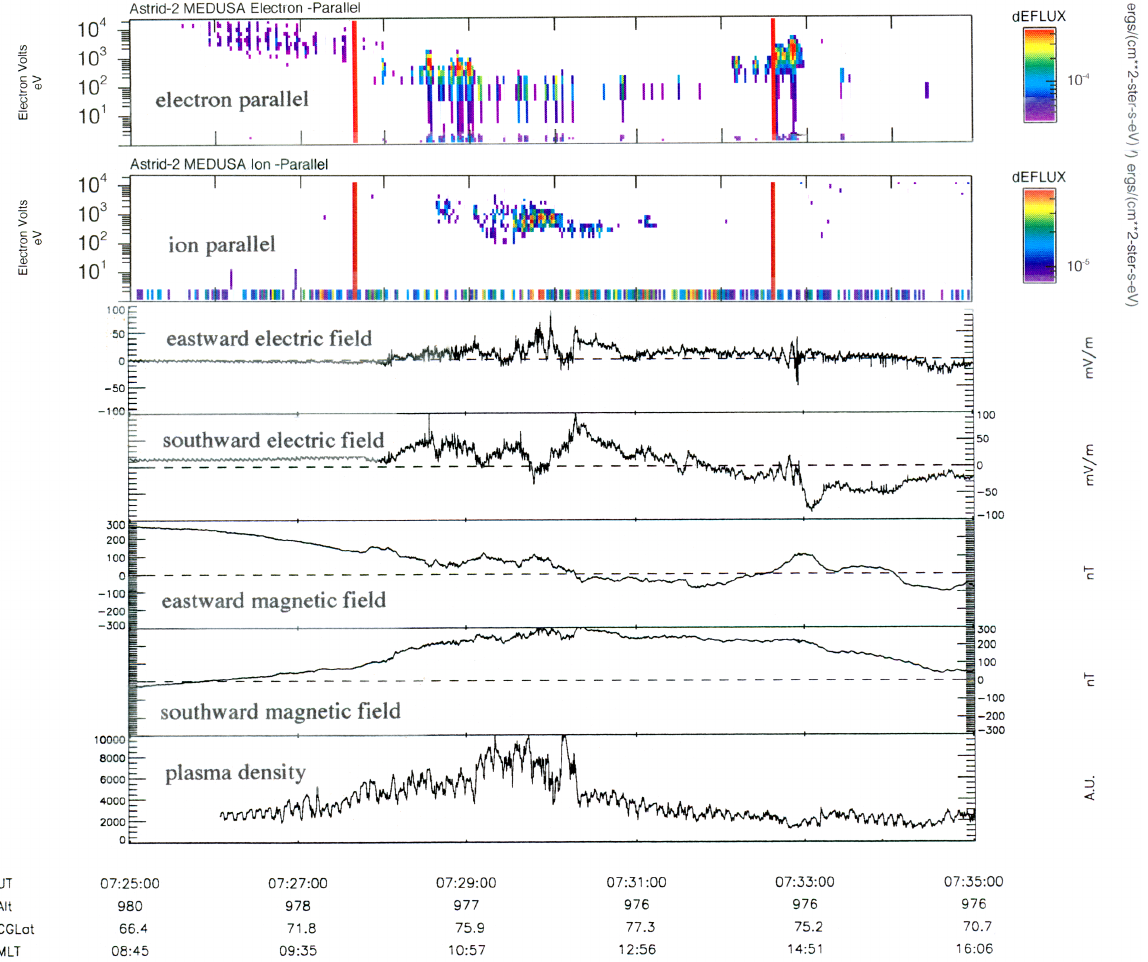
Fig. 3. Observations from a dayside orbit through the polar cusp on 7 May 1999. The panels show from top to bottom; energy time spectrograms of electrons and ions parallel to the geomagnetic field; the geomagnetic eastward and equatorward components of the electric and magnetic field, respectively; and the plasma density measured by the Langmuir